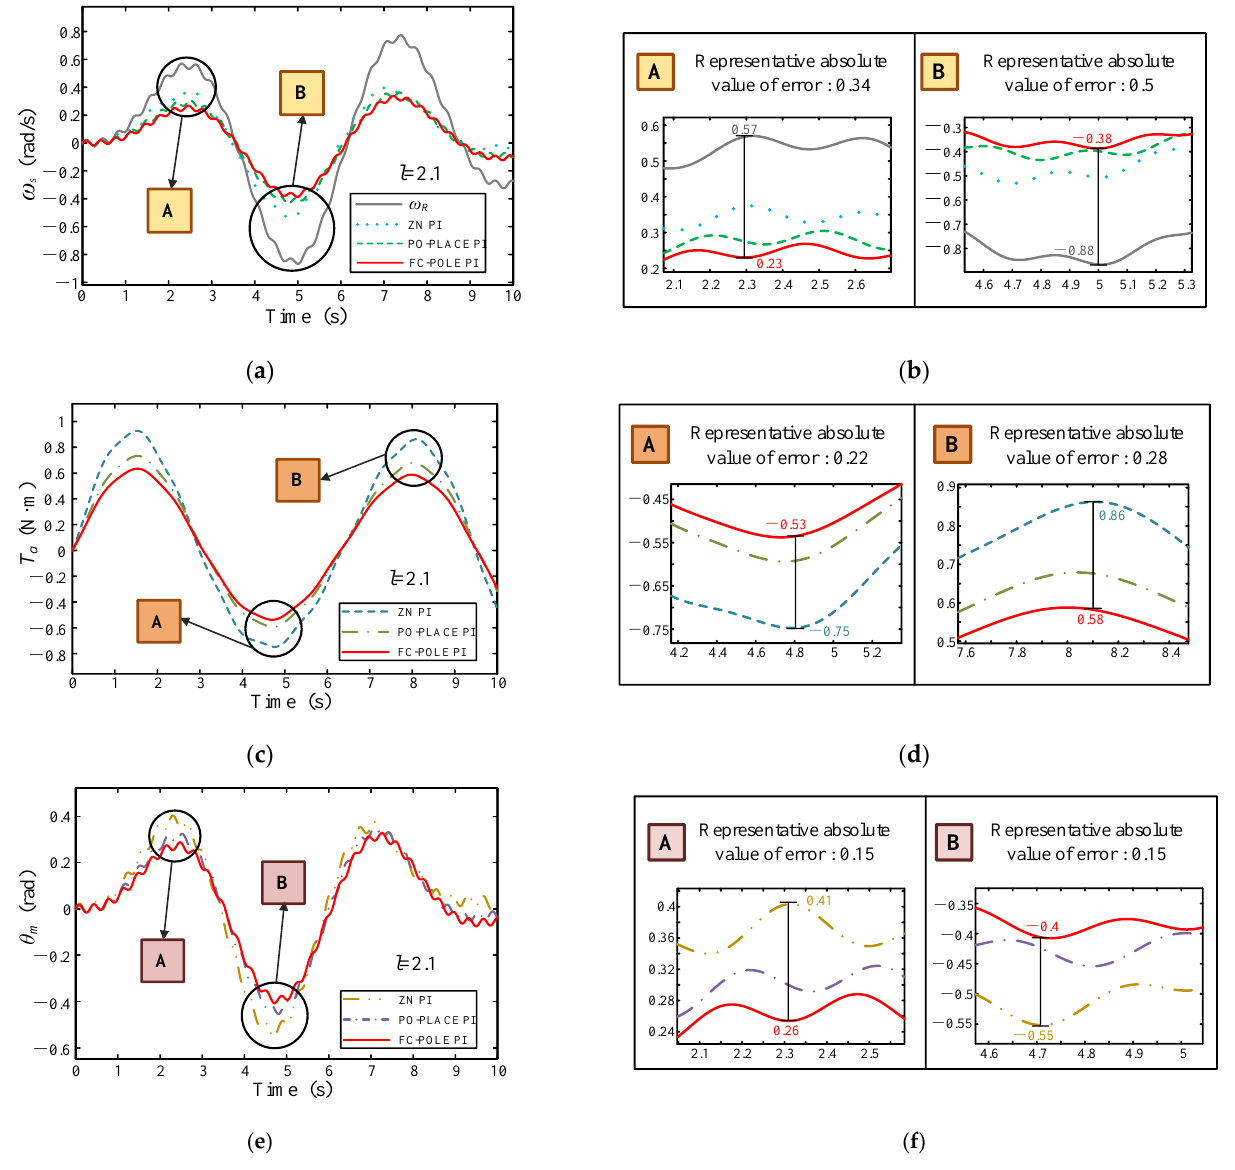
Figure 8. Output curve of double flexible body under parameter 3: ( a ) system rotation frequency diagram; ( b ) local amplification diagram of rotation frequency; ( c ) system torque diagram; ( d ) local amplification diagram of system torque; ( e ) system output angle diagram; ( f ) local magnification of system output angle.